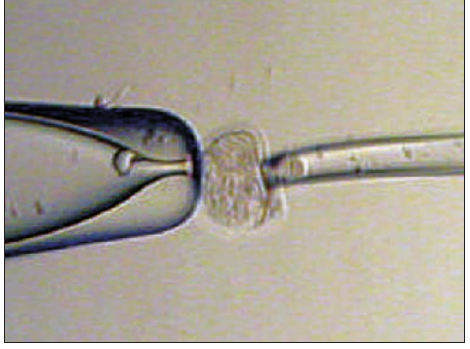
Fig. 1 Aspiration of the blastomeres during embryo